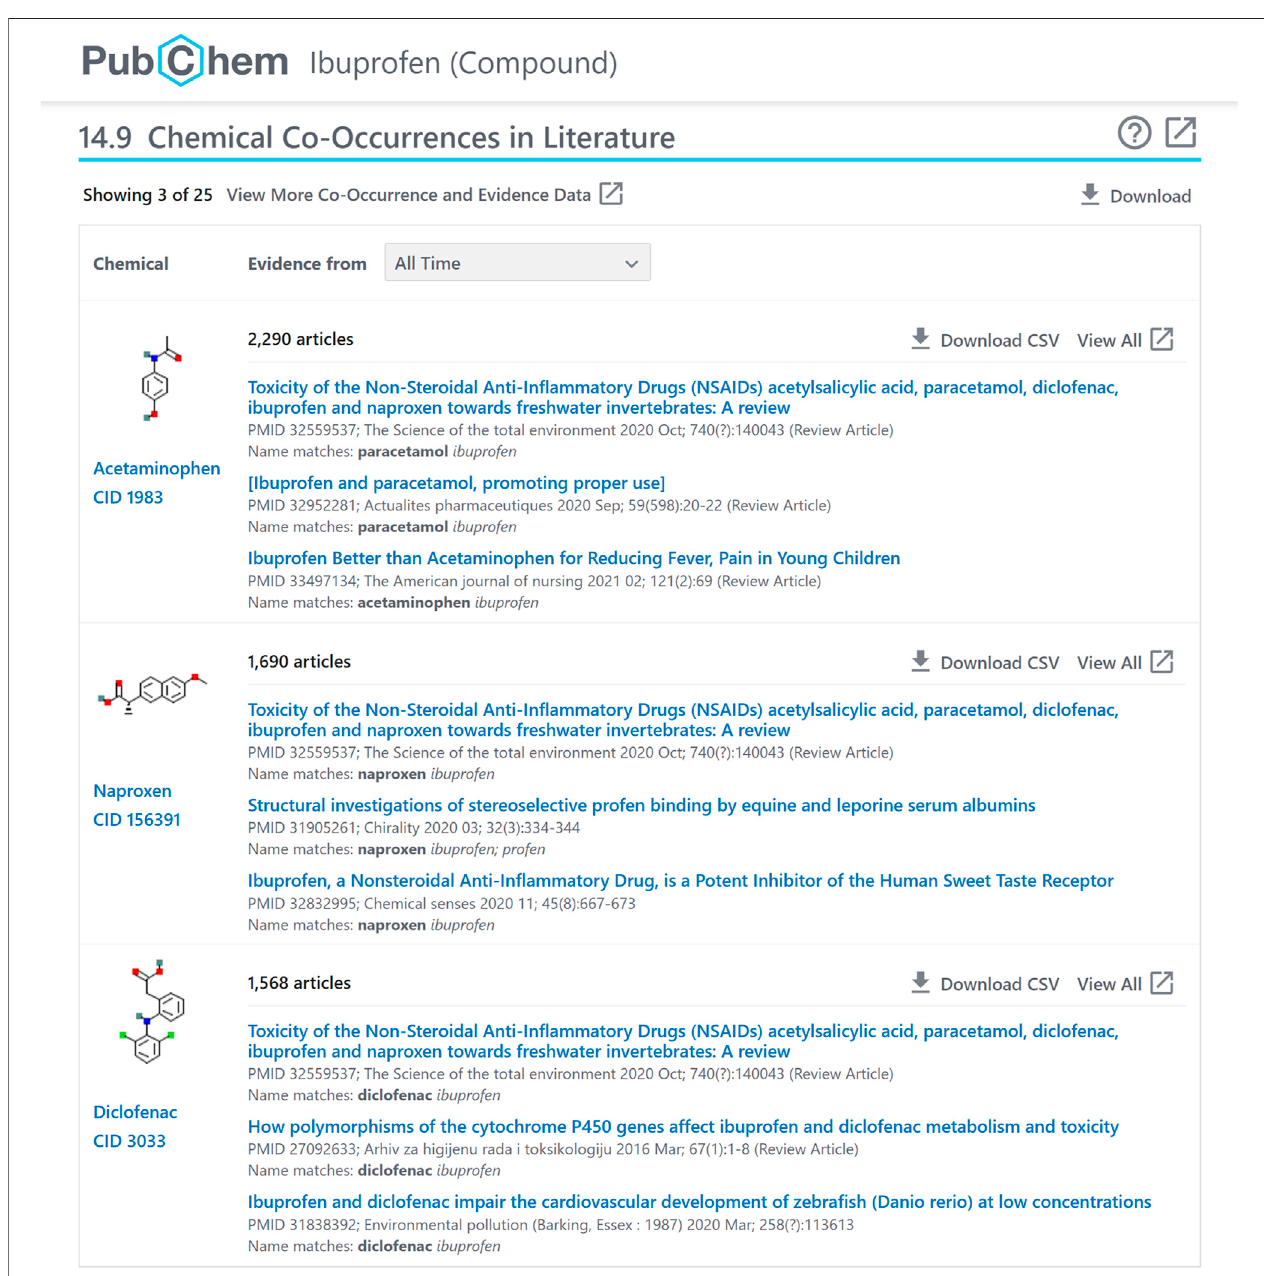
FIGURE 1 | Chemical-chemical co-occurrence panel for ibuprofen (CID 3672), accessible at: https://pubchem.ncbi.nlm.nih.gov/compound/ 3672#section (cid:2) Chemical-Co-Occurrences-in-Literature.